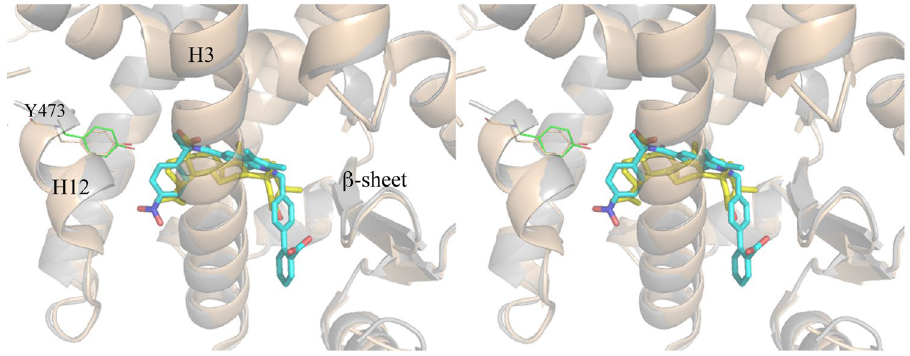
Figure 5. Superposition of PPAR γ /BA and PPAR γ /SR1664 crystal structures. Stereo view of the superposed crystal structures of PPAR γ /BA (cartoon grey, BA yellow) and PPAR γ /SR1664 complexes (cartoon wheat, SR1664 cyan).